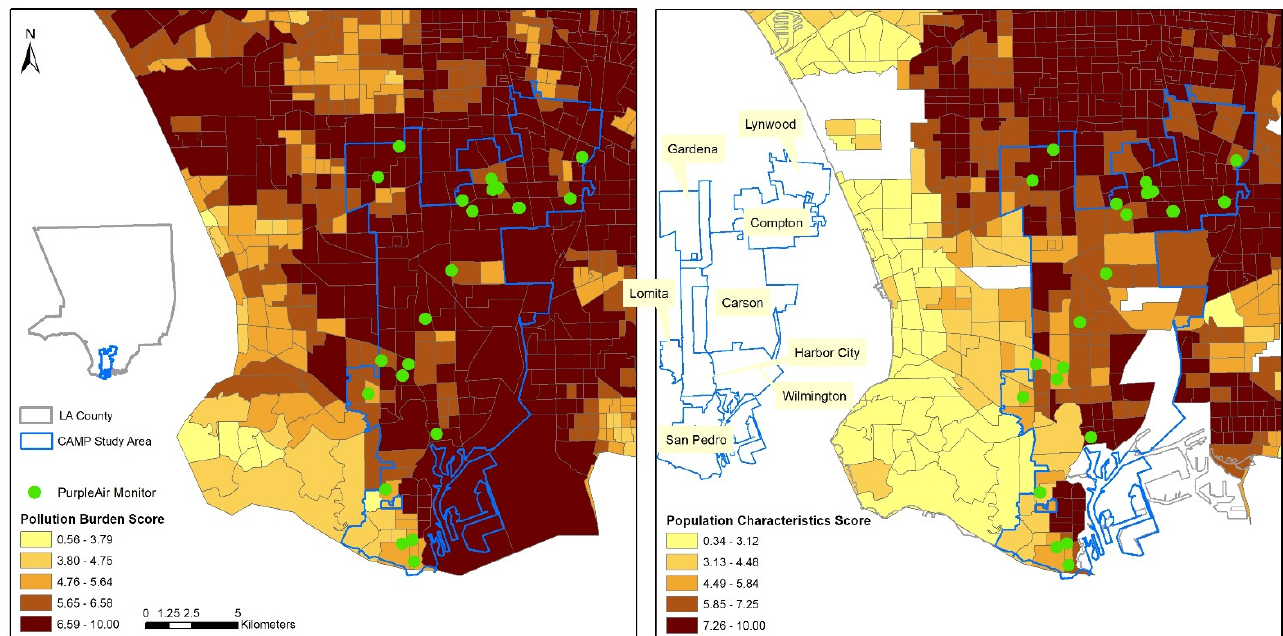
Figure 1. CAMP study area with the pollution burden and population characteristics.